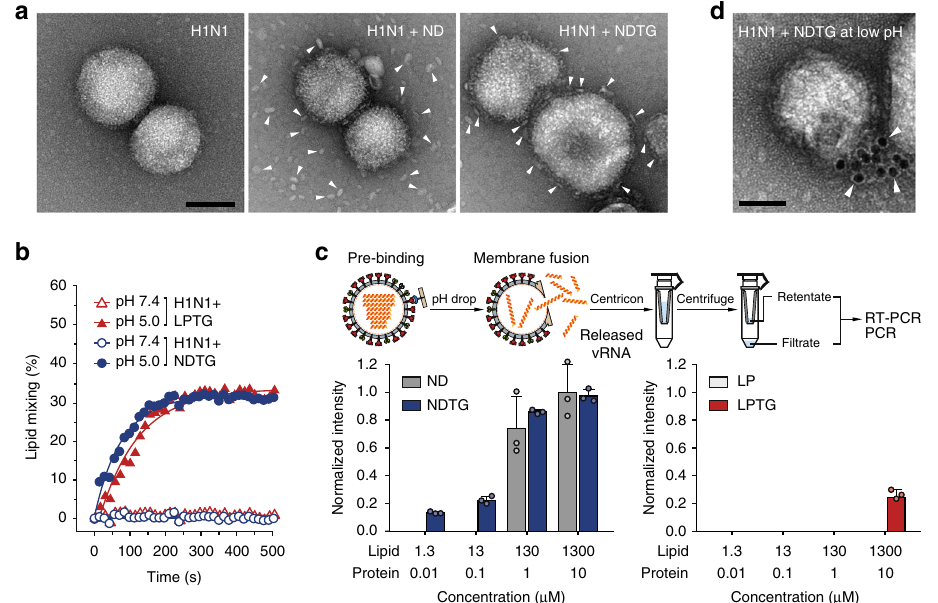
Fig. 2 Perforation of viral envelope through membrane fusion at low pH. a EM analysis of H1N1 virus alone, mixture of ND and H1N1, and mixture of NDTG and H1N1. White arrows indicate ND or NDTG. Scale bar, 100 nm. b Lipid mixing assay monitored by dequenching of NBD fl uorescence following fusion of the nanodisc and virus. c Release of vRNPs from viruses. After virus fusion with ND, NDTG, LP or LPTG was triggered at pH 5.0, vRNP release was analysed by RT-PCR for the viral M gene following centrifugation with a centrifugal fi lter. Data are expressed as the mean ± SD of three independent experiments. d Immunogold labelling of vRNPs released from the H1N1 virus after incubation with NDTG at low pH. White arrows indicate gold particles bound to the released vRNPs. Scale bar, 50